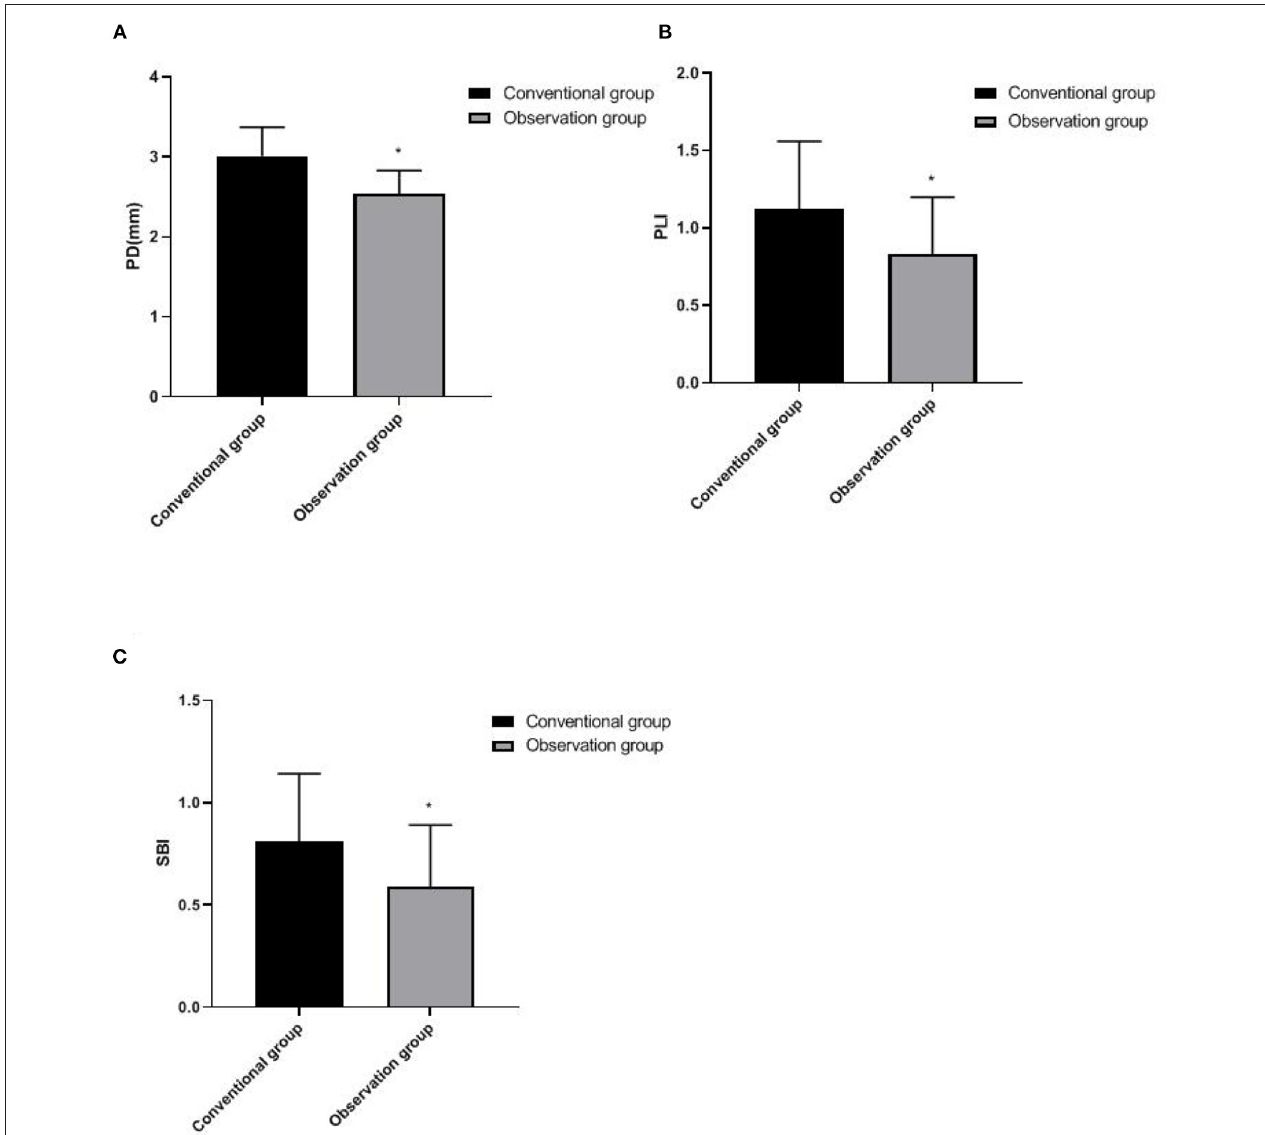
FIGURE 3 | Comparison of periodontal index between two groups. (A) PD, (B) PLI, and (C) SBI. Compared with the conventional group, * p <